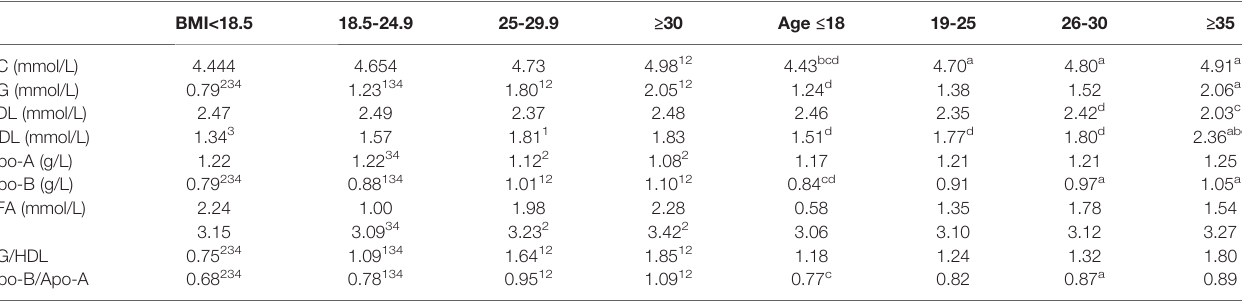
TABLE 3C | Comparison of lipid parameters in women with PCOS according to body mass index and age